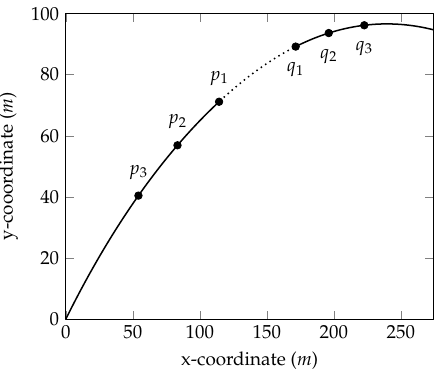
Figure 4. The three entry points for the blending spline transition curve on the circular segments.